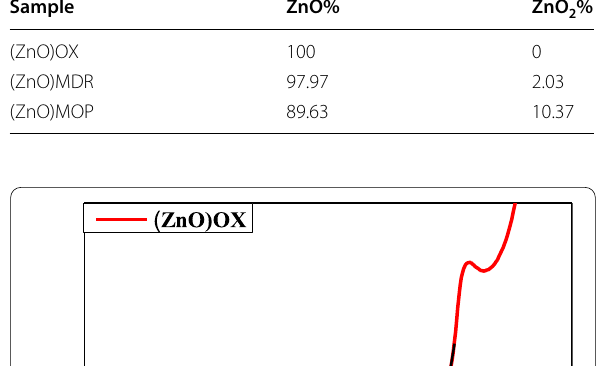
Fig. 2 The calculation of the band gap energy of zinc oxide (ZnO) nanoparticles